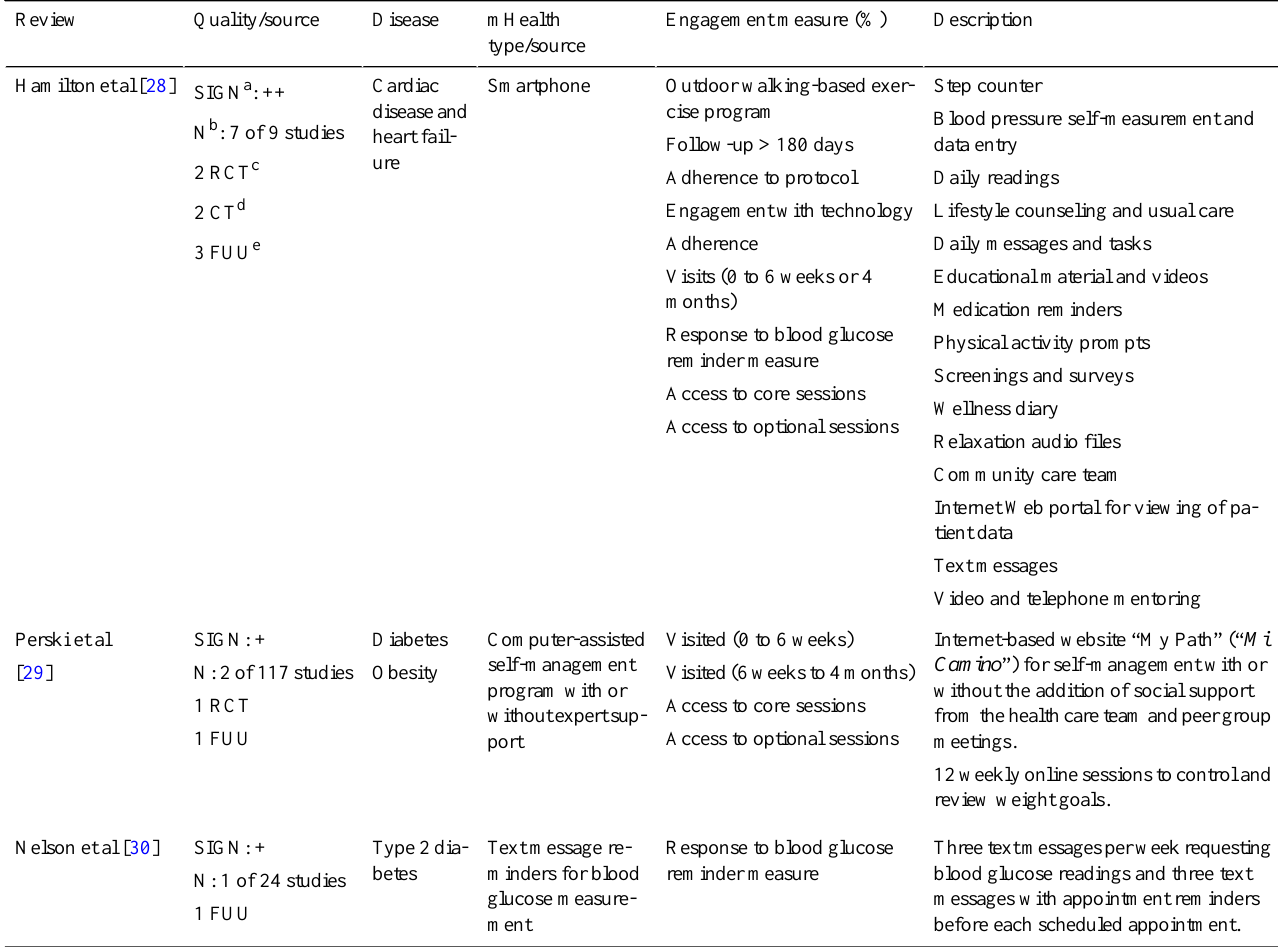
Table 1. Characteristics of systematic reviews and patient